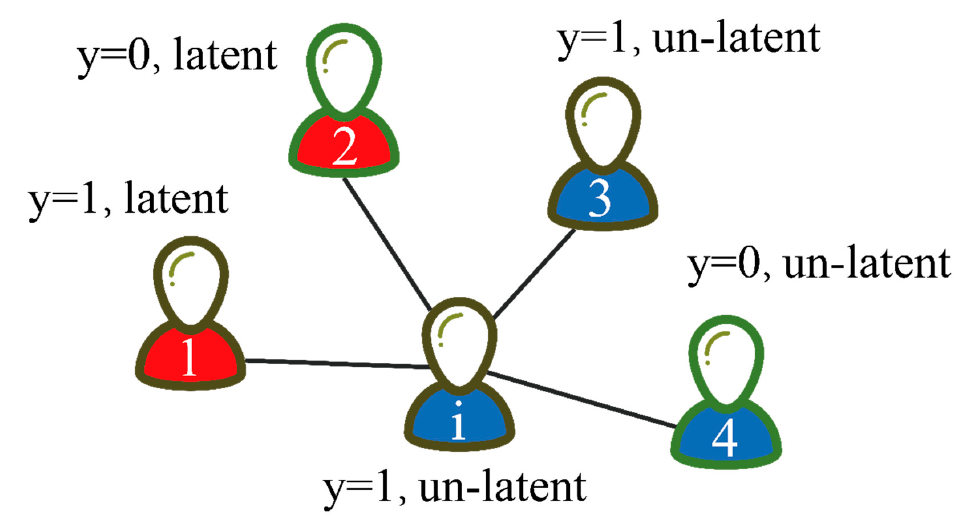
Figure 3. Diagram of farmers’ social network (FSN).